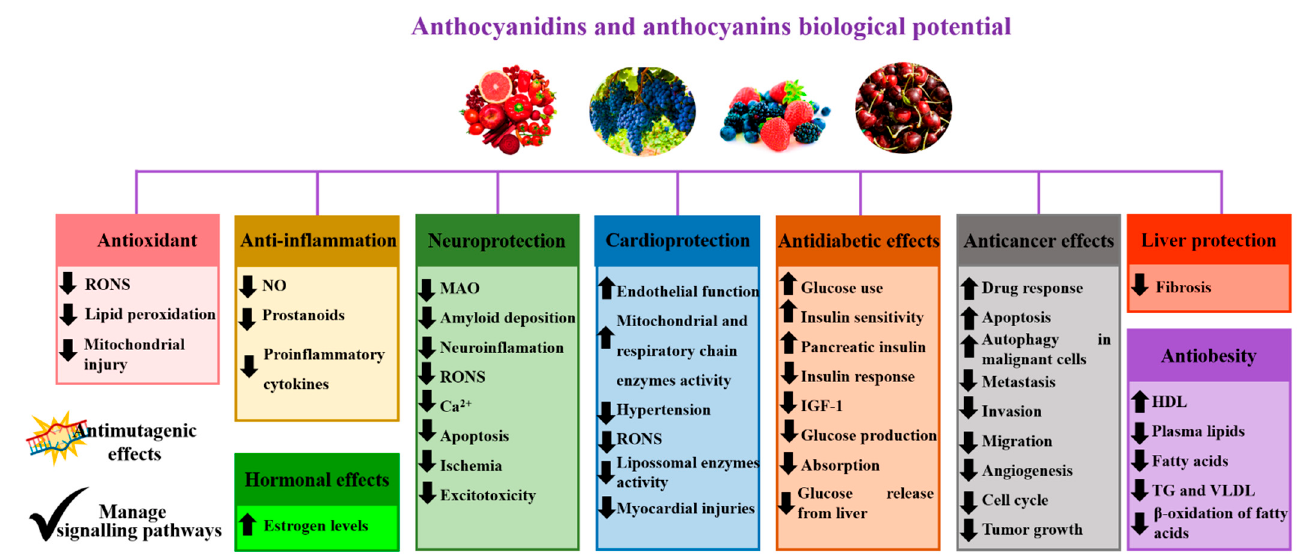
Figure 1. Main biological potential attributed to anthocyanidins and anthocyanins. ↑ : increase; ↓ : decrease; RONS: reactive oxygen and nitrogen species; NO: nitric oxide; MAO: monoamine oxidase; IGF-1: insulin-like growth factor 1; TG: triglycerides; VLDL: very low-density lipoprotein; HDL: high-density lipoprotein. Adapted from [8,10–19].